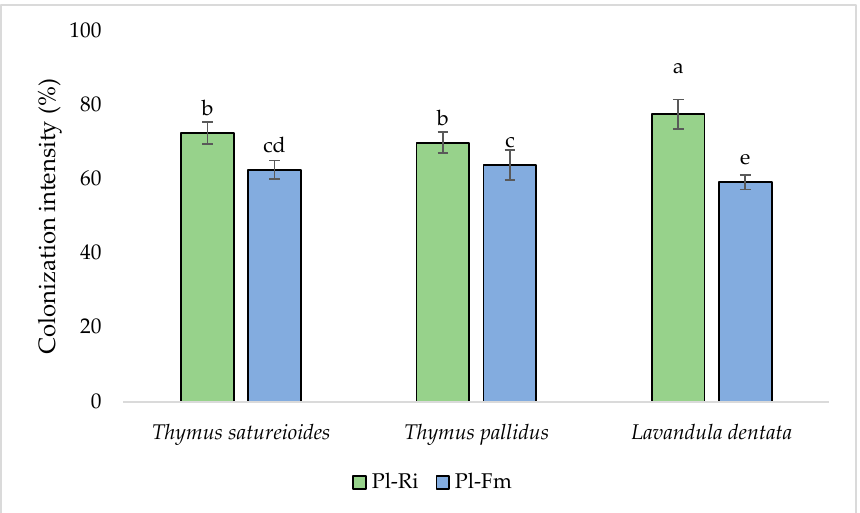
Figure 1. Intensity of mycorrhizal colonization (%) in roots of Thymus satureioides (Ts), Thymus pallidus (Tp), and Lavandula dentata (Ld) inoculated with Rhizophagus irregularis (Ri) or Funneliformis mosseae (Fm) after 4 months of culture under greenhouse conditions. Bars followed by the same letter are not significantly different according to Tukey’s HSD test ( p < 0.05).